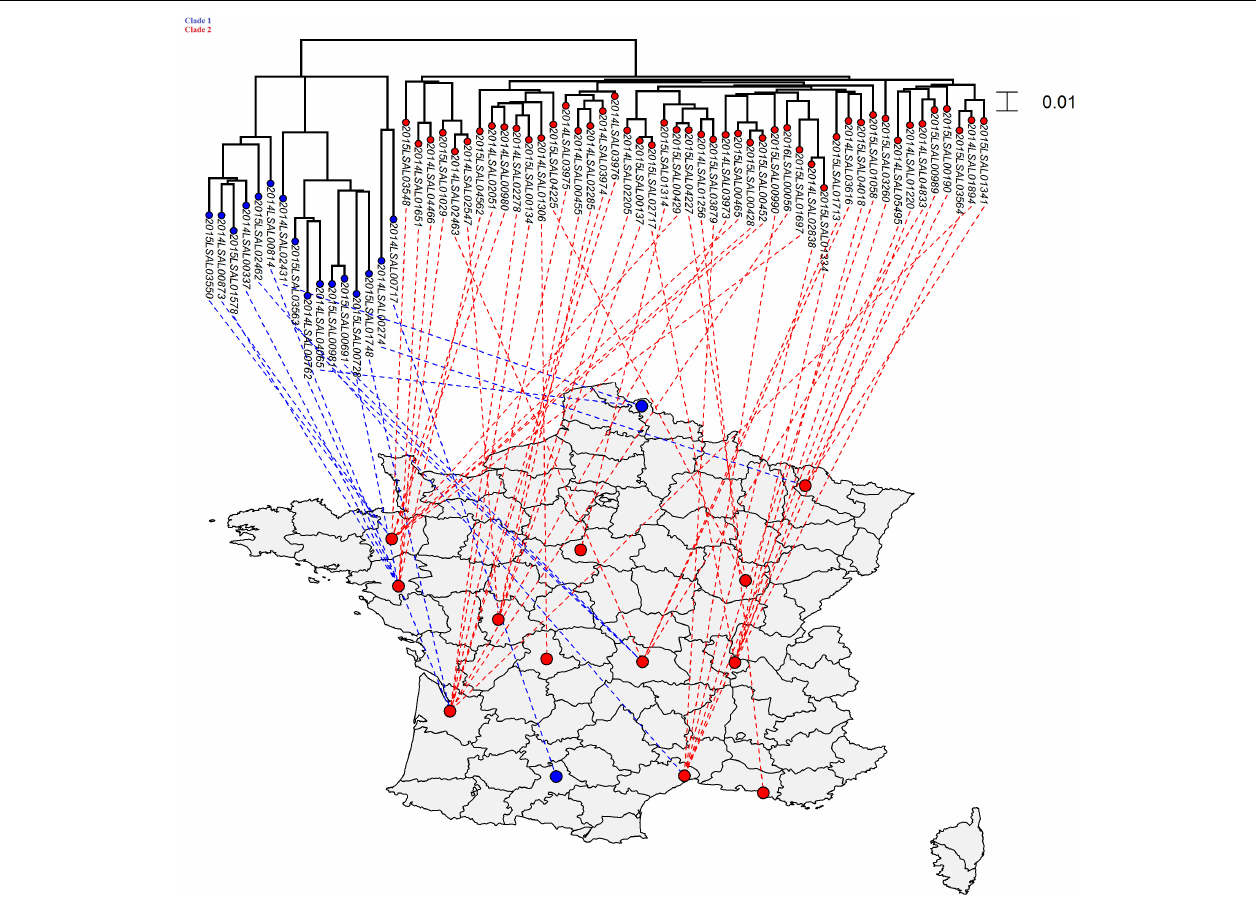
FIGURE 2 | Phylogenetic SNP distribution of the strains from the cluster ST40 in relation with their geographical repartition. Tree was constructed under the maximum likelihood criterion using the GTR-gamma model. The scale bar indicates number of substitutions per site. Two distinct clades were identified. There is no apparent correlation between geographical and phylogenetic distribution of the different strains belonging to these two